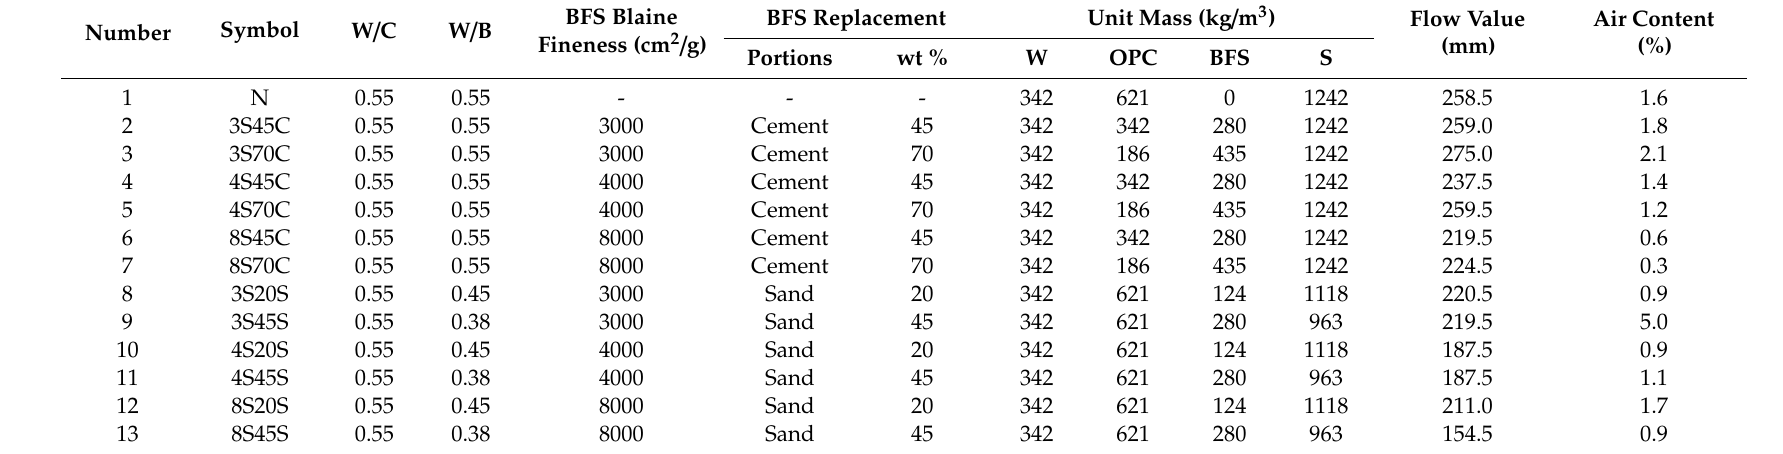
Table 2. Mixture proportions of all the investigated